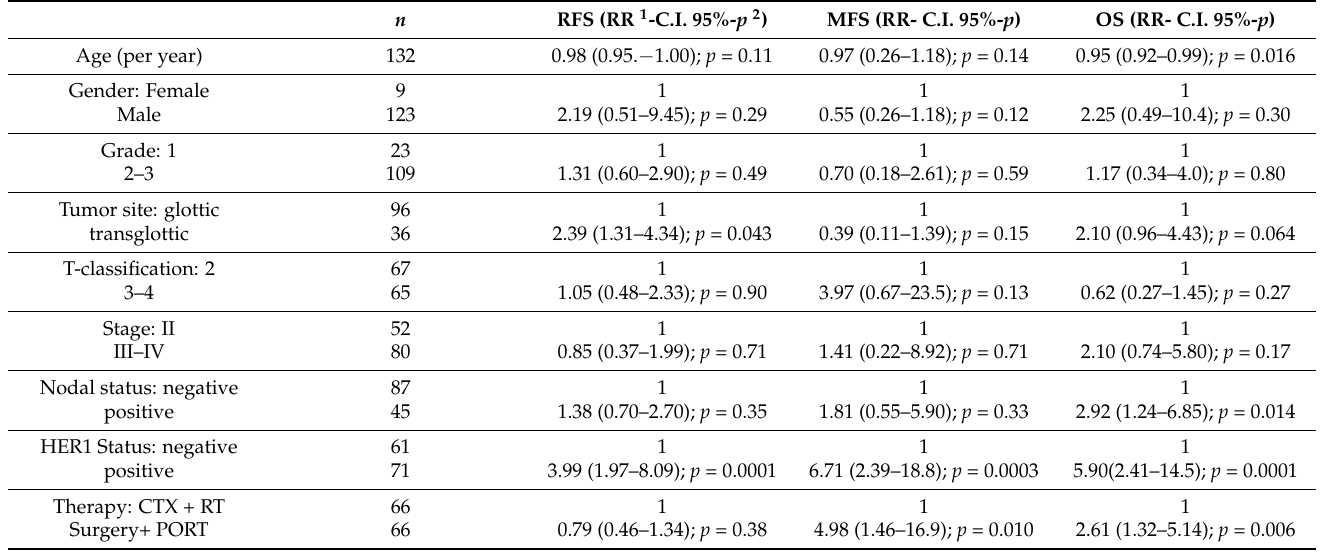
Table 5. Multivariable modeling of predictors for relapse-free, metastasis-free, and overall sur- vival in the cohorts of LALSCC patients weighted for the inverse estimates of the probability of Cetuximab + radiotherapy (CTX + RT) or up-front surgery + radiochemotherapy (SURG + RCT)